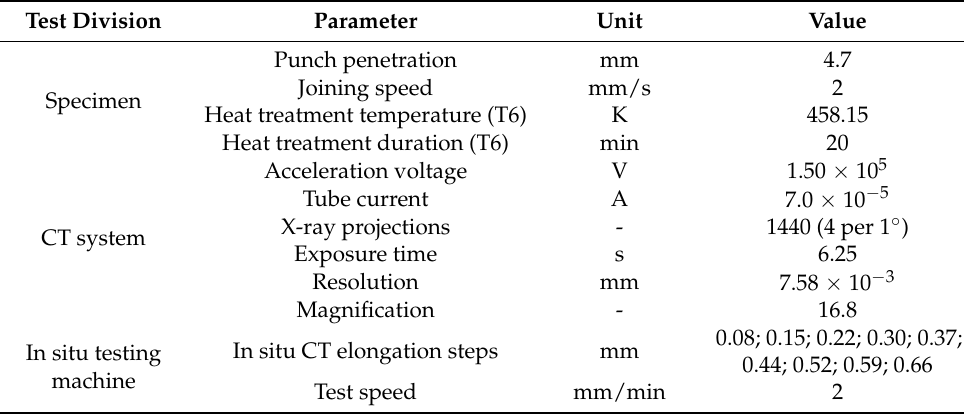
Table 1. Test and specimen manufacturing